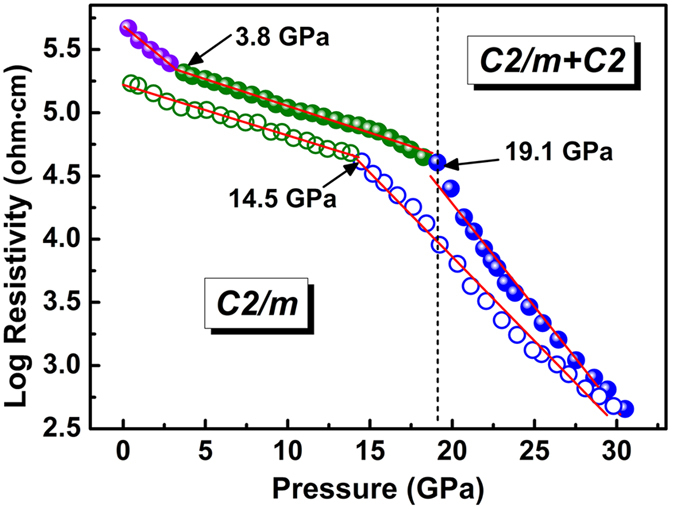
Resistivity as a function of pressure for MgV2O6 at room temperature.